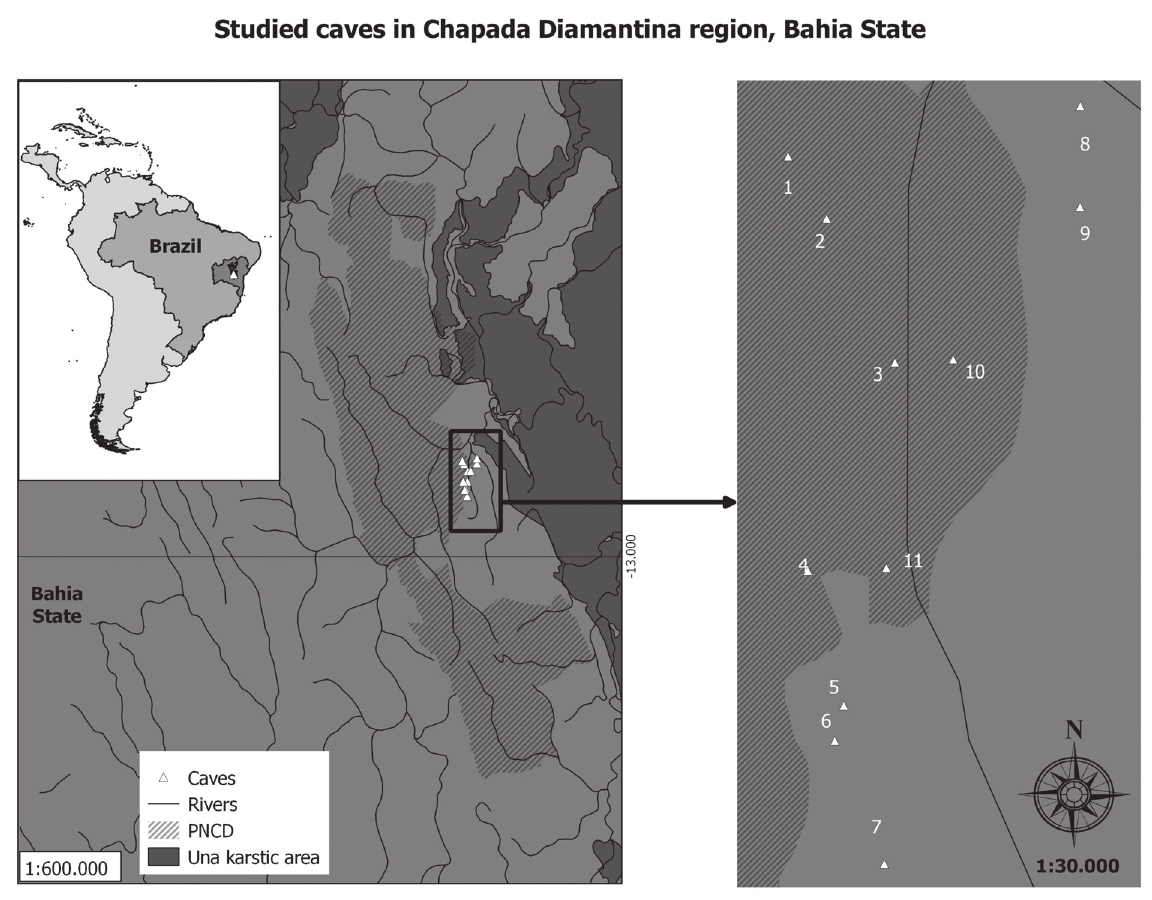
Figure 1 - Studied caves in the Chapada Diamantina region, state of Bahia. 1-Cantinho cave; 2-Criminoso cave; 3-Torras System; 4-Canal da Fumaça cave; 5-Rio dos Pombos cave; 6-Ressurgência do Morro de Alvo cave; 7-Morro de Alvo cave; 8-Veio de Aurélio cave; 9-Cobras cave; 10-Parede Vermelha cave; 11-Lava Pé cave. PNCD – Parque Nacional da Chapada Diamantina (National Park of Chapada